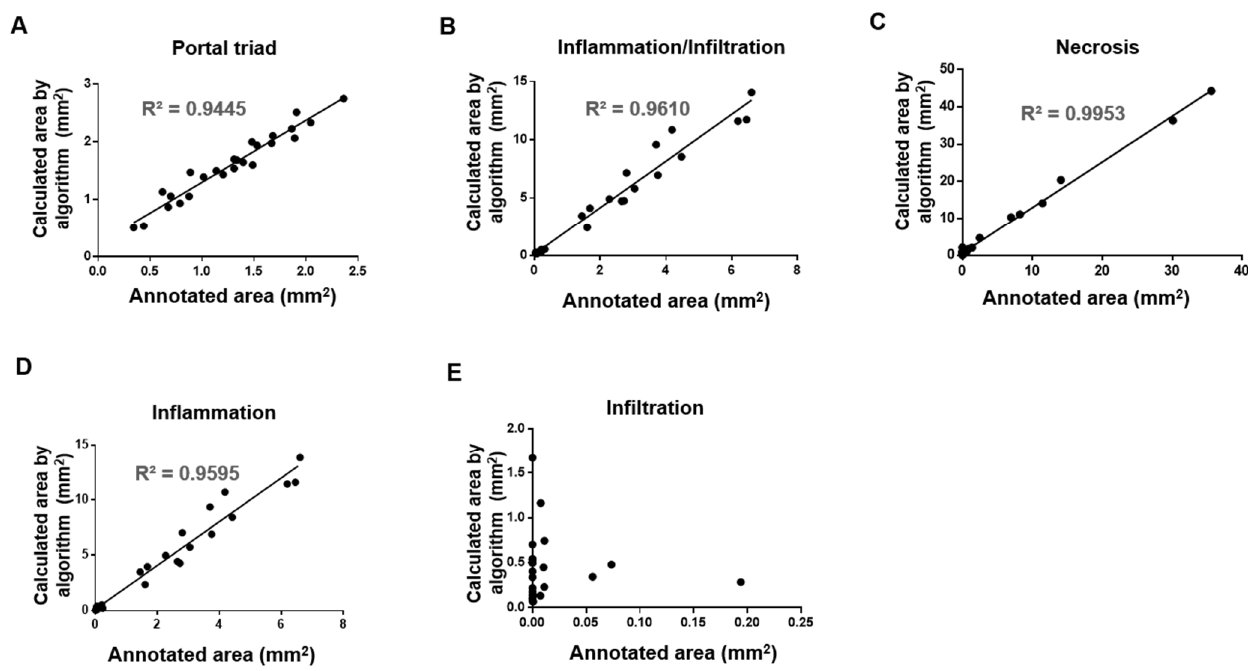
Figure 5. Correlations between annotated area and algorithm-predicted area. The areas annotated by an accredited toxicologic pathologist were compared by linear regression with those predicted by the established algorithm for portal triad ( A ), inflammation and infiltration together ( B ), necrosis ( C ), inflammation ( D ), and infiltration ( E ). The prediction was performed using 20× magnification- scale images.